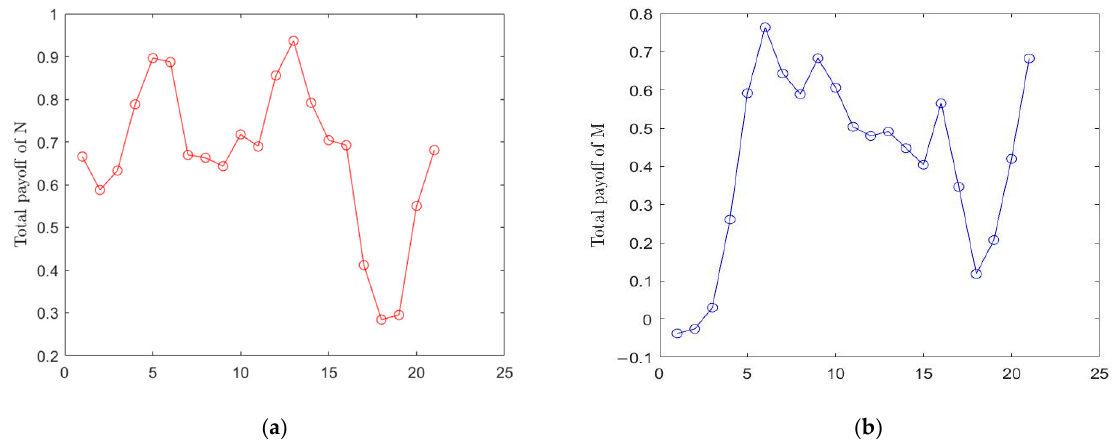
Figure 5. The total payoff function change curves of the N and M sides in the first layer decision.